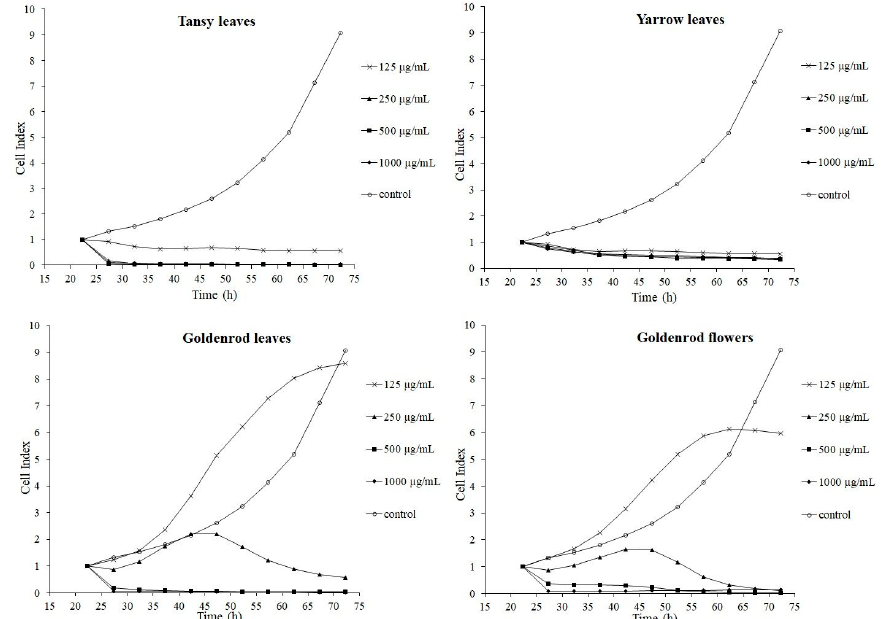
Figure 1. Cell index curves for porcine intestinal epithelial cell line (IPEC-1) cells incubated with tansy, yarrow, goldenrod leaves and goldenrod